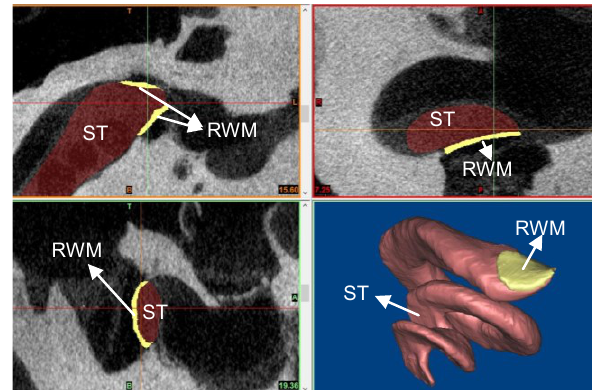
Fig.9. Segmentation of the round window membrane.